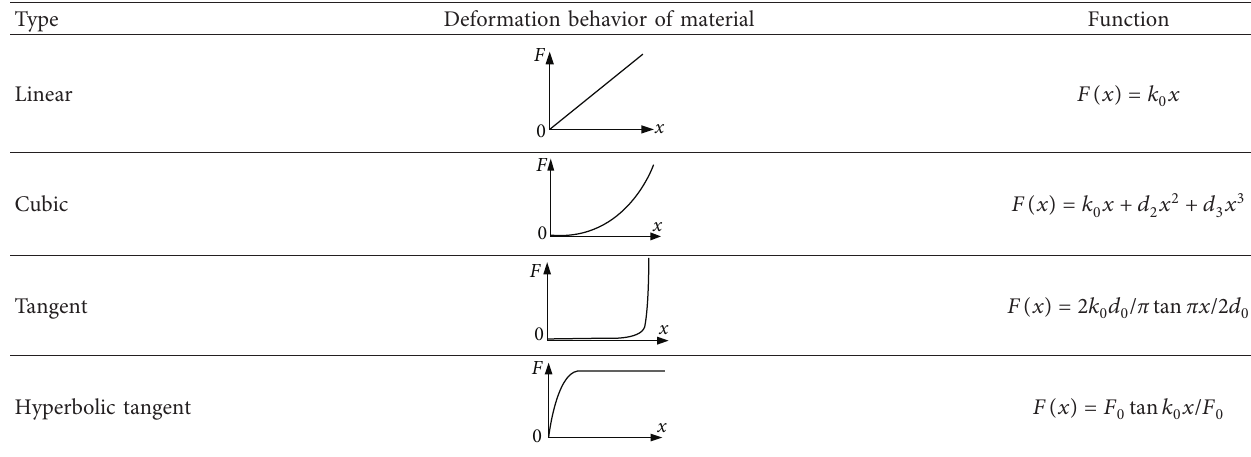
Table 2: Stiffness functions of cushioning